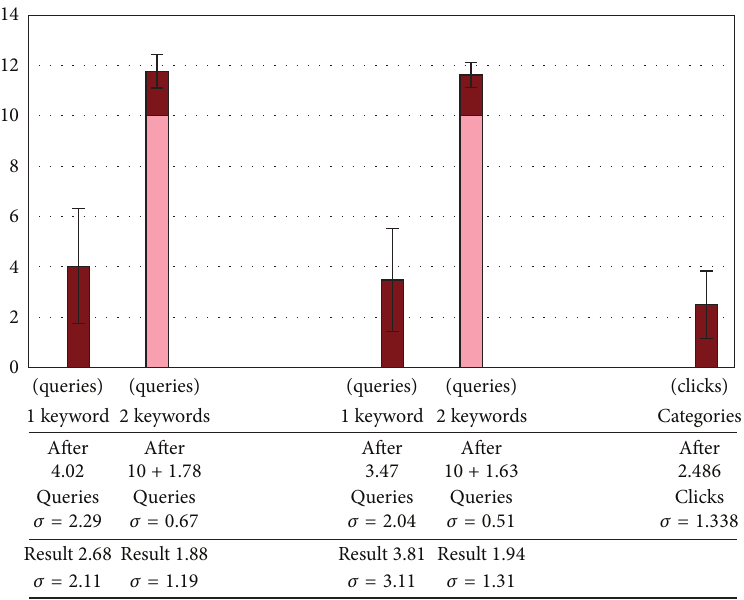
Figure 8: Number of queries actually typed before having a result including the named entity among the first 10 results and, below, the ranking of the result that included the named entity, using the database’s text search engine (left) and using Google (center), and numbers of clicks, after the first query, to find the name using our system (right).